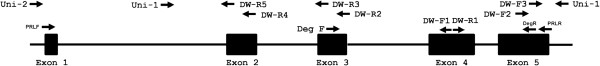
Structure of gene encoding PRL of cinnamon clownfish A. melanopus. Positions corresponding to the primers used for PCR amplification are presented by arrows. PCR primers Deg-F and Deg-R were designed from the conserved regions of prolactins reported from other species in Genbank. DW-F and DW-R indicate primers used for DNA walking to obtain a full-length prolactin gene. Exons are represented by dark boxes and introns are represented by lines.